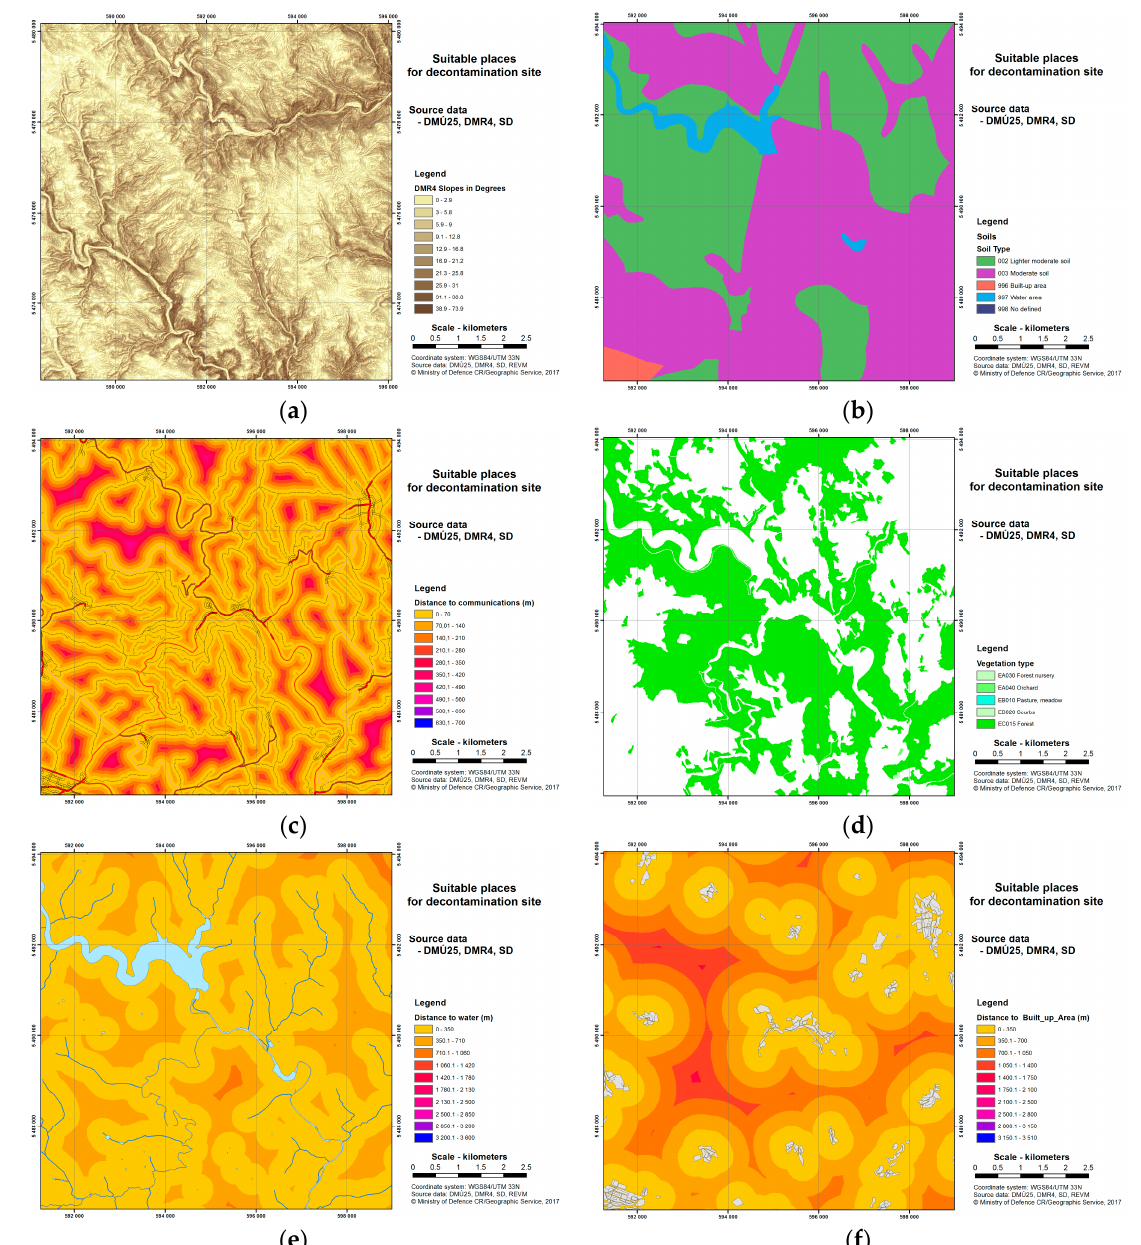
Figure 6. ( a ) Cutout of a raster layer of inclination of slopes analyzed from the raster digital elevation model (DMR4). ( b ) Cutout of a raster layer of soil types. ( c ) Cutout of a raster layer of Euclidean distance to communications. ( d ) Cutout of a raster layer of vegetation types. ( e ) Cutout of a raster layer of Euclidean distance to waters. ( f ) Cutout of a raster layer of Euclidean distance to built-up area.